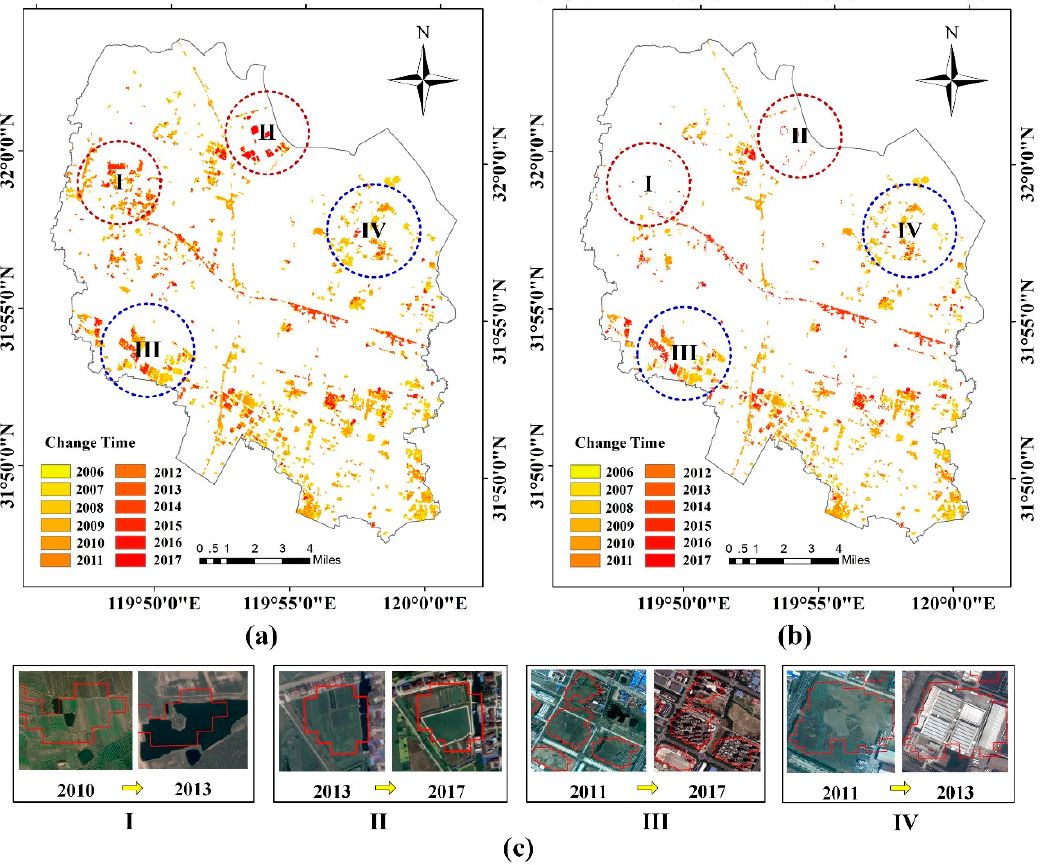
Figure 9. Impervious surface expansion extraction results. ( a ) SVM classification results. ( b ) Multi-level classification results. ( c ) Comparison of areas I, II, III, and IV using high-resolution imagery.